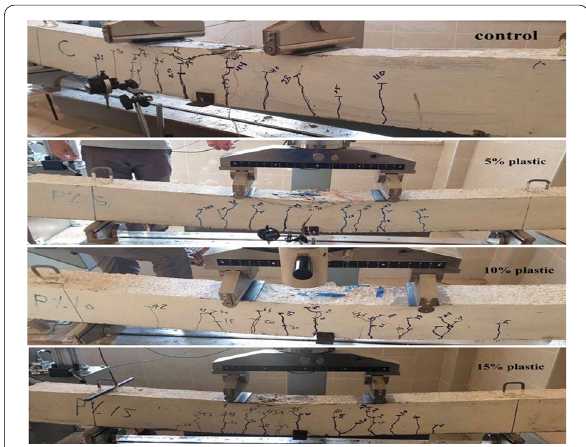
Fig. 17 Failure mode of beams containing granular plastic.